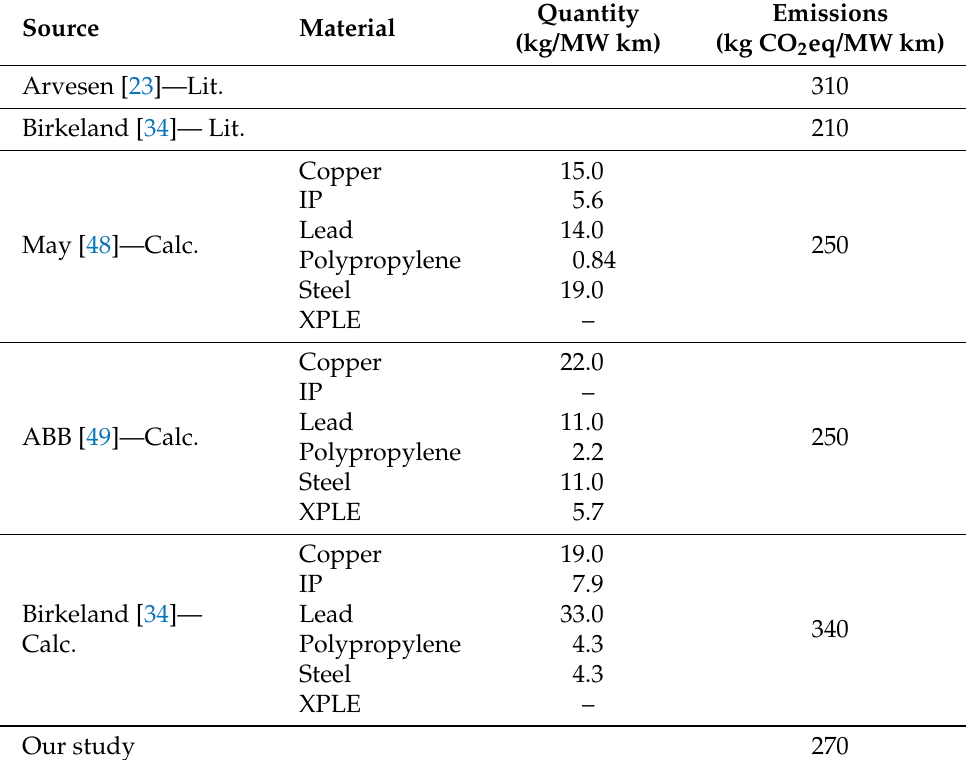
Table 2. Life cycle inventory of 1MWkm HVDC